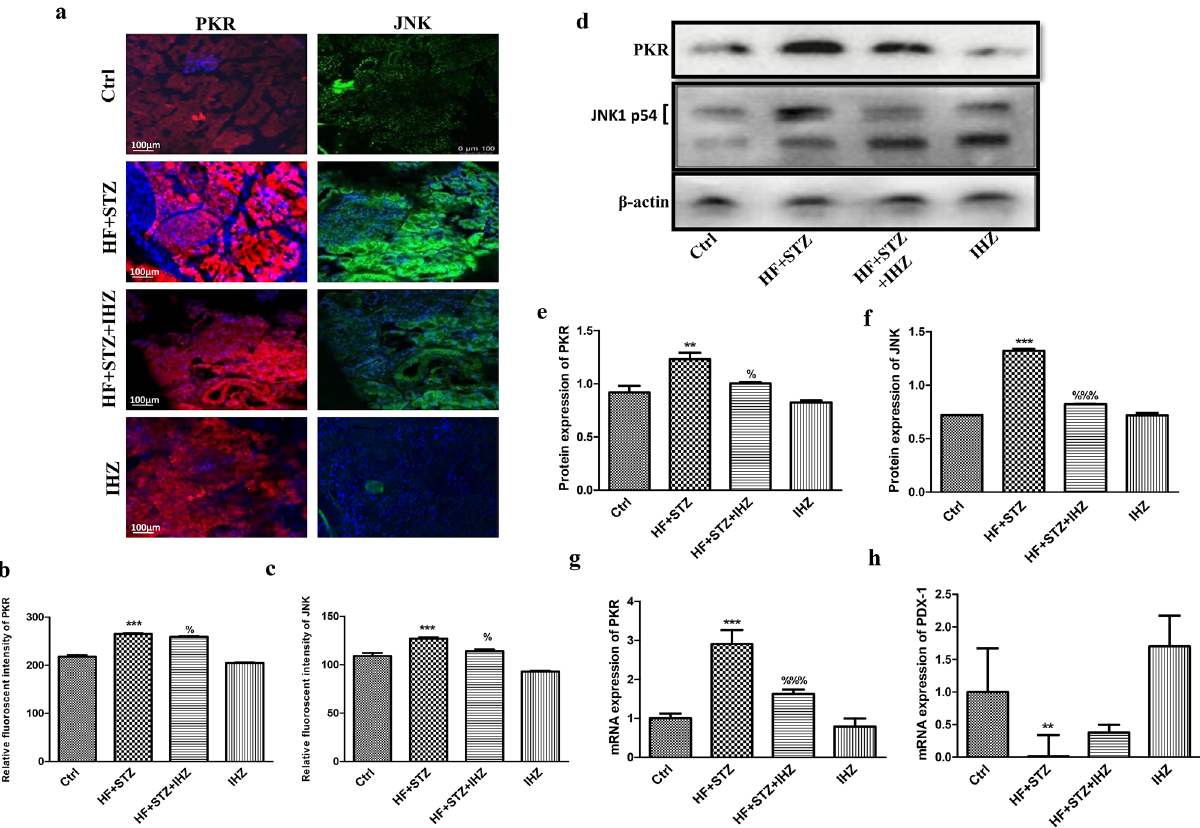
Figure 5. IHZ attenuates islet damage and fibrosis in pancreatic tissue of diabetic rats via inhibition of JNK signaling pathway. ( a ) PKR and JNK protein expression in pancreatic tissue detected by immunohistochemistry using suitable antibodies (representative images). ( b , c ) Quantitative data of ( a ). ( d ) Representative western blots showing the levels of PKR and JNK. β-actin was used as loading control. ( e , f ) Quantitative data of ( d ). ( g ) mRNA levels of PKR as detected by qRT-PCR. ( h ) mRNA levels of PDX-1 detected by qRT-PCR ( d ); Data is presented as mean ± SD of n = 3 animals for each group. **P < 0.01, ***P < 0.001 vs control group; %P < 0.05, %%%P < 0.001 vs HF + STZ